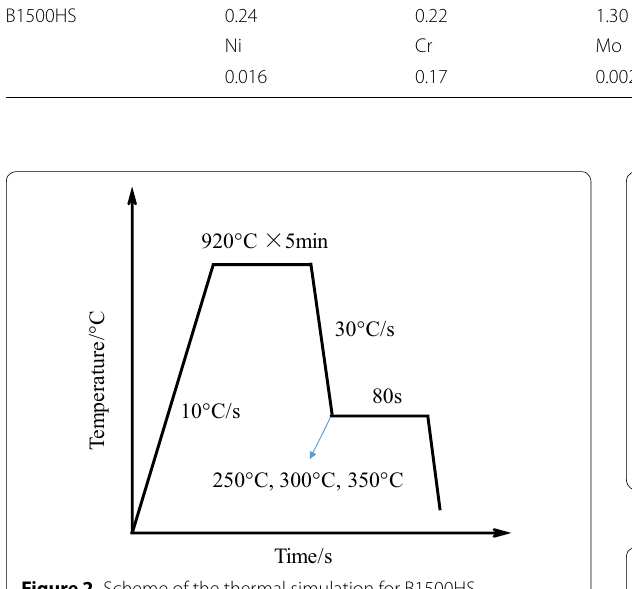
Figure 2 Scheme of the thermal simulation for B1500HS